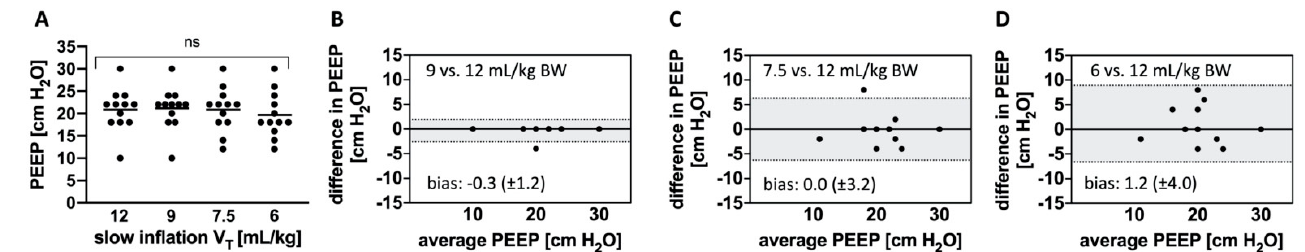
Figure 5. ( A ) Electrical impedance tomography (EIT)-based positive end-expiratory pressure (PEEP) levels derived from EIT-based regional ventilation delay measurements from different slow inflation tidal volume (V T ) during a decremental PEEP trial. Dots indicate individual PEEP levels. Solid lines show means. ns = not significant, repeated-measures analysis of variance (ANOVA). ( B – D ) Bland–Altman comparisons of EIT-based PEEP levels derived from ( B ) 9, ( C ) 7.5, and ( D ) 6 mL/kg of body weight (BW) with the original 12 mL/kg BW slow inflation. Bias ± standard deviations of bias are shown within the graphs. Limits of agreement are indicated by the dotted lines enclosing the gray areas.